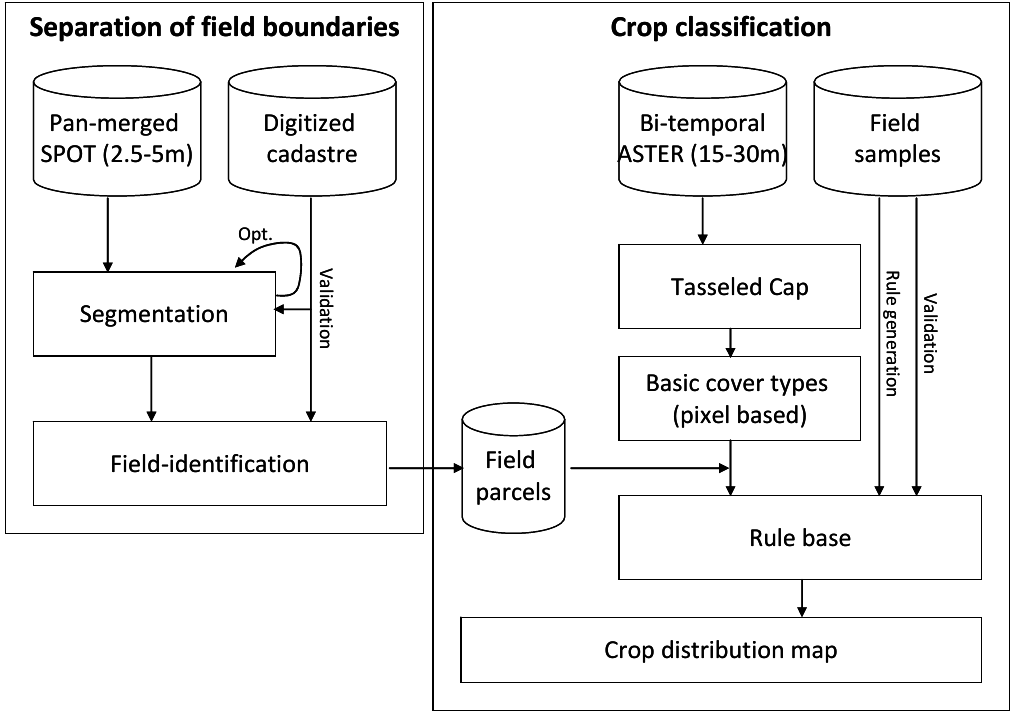
Figure 3. Schematic workflow of the study. The left part shows the separation of field boundaries for per-field classification, the right part highlights the classification